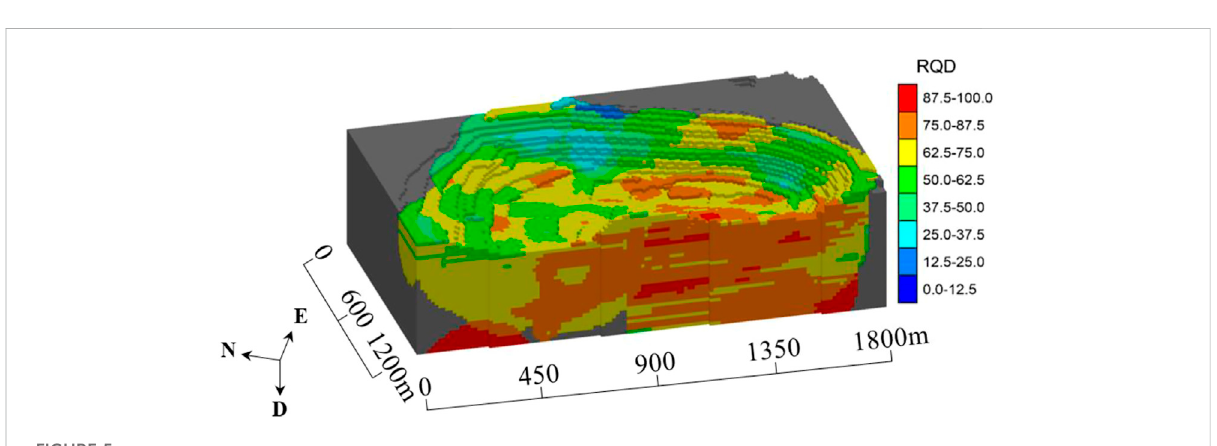
FIGURE 5 RQD block